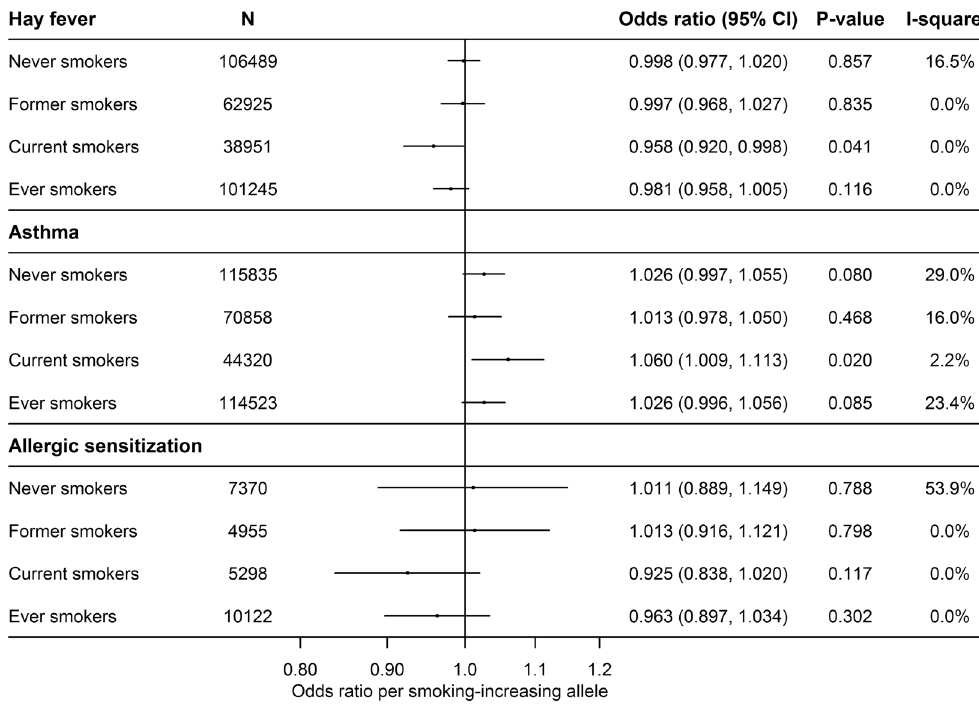
Figure 3. Mendelian randomization analysis of the age- and sex-adjusted associations of rs1051730 or rs16969968 and hay fever (N = 208,365), asthma (N = 231,013) and allergic sensitization (N = 17,623) using fixed effect meta-analysis, except for allergic sensitization where we used random effect meta-analysis. Please note that the sum of former and current smokers is not equal to the number of ever smokers since GOYA Females are included in current smokers but not in ever